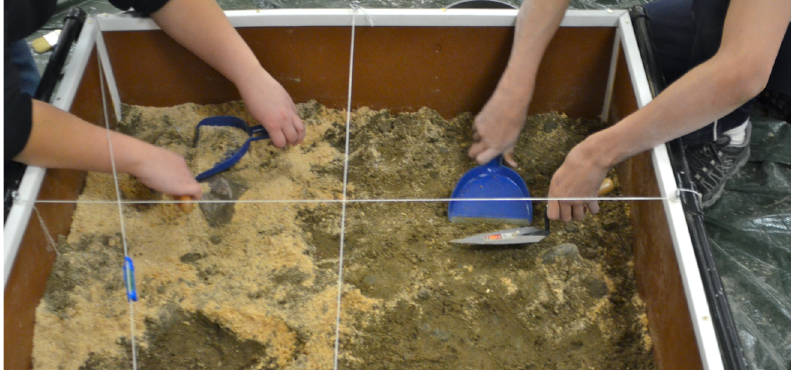
Figure 7: A group of Iqaluit Inuksuk High School students conduct an excavation during a pilot trial of the kit in December 2015. Photo by Brendan